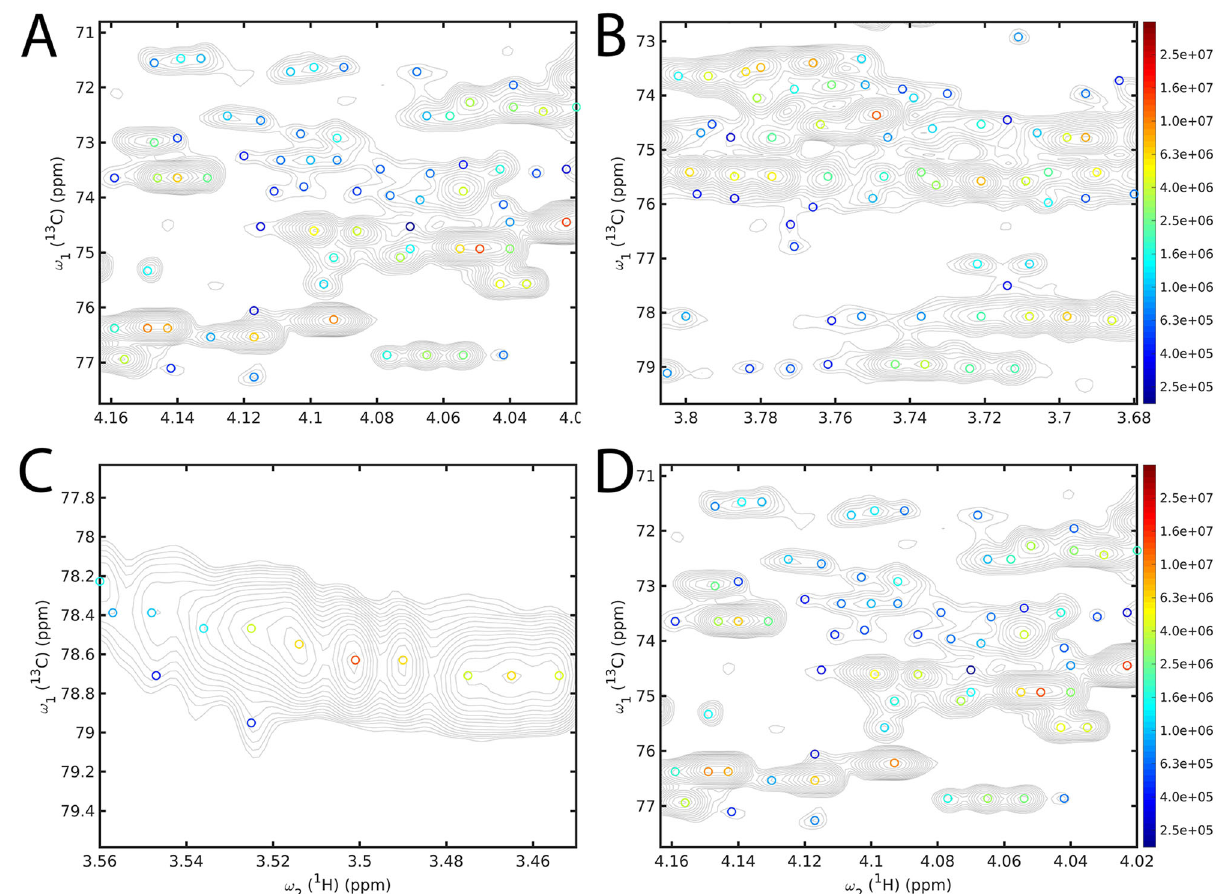
Fig. 7 Illustration of performance of DEEP Picker for 2D 13 C – 1 H HSQC of mouse urine. Selected spectral regions are depicted in Panels A – D , which include the highly crowded carbohydrate region. DEEP Picker is able to identify and distinguish between cross-peaks that strongly overlap, which poses a signi fi cant challenge for their analysis by traditional peak pickers. Picked cross-peaks are indicated as circles and color-coded according to their amplitude on a logarithmic scale with logarithmic contour line